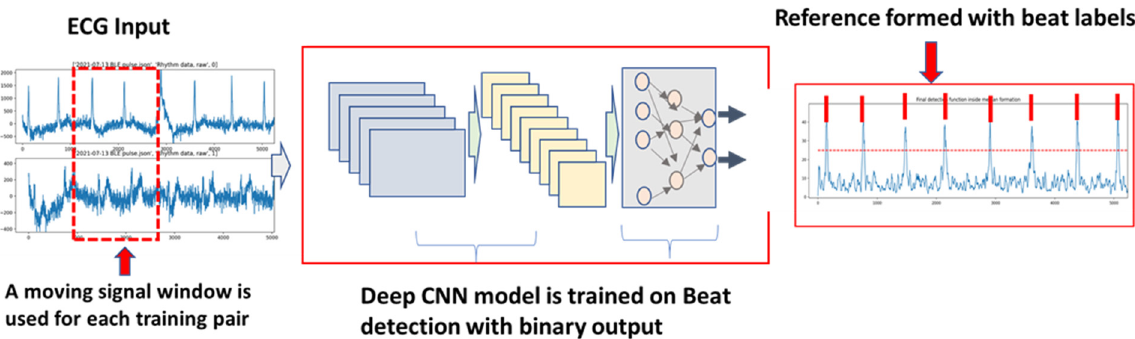
Figure 5. DL models can be trained for beat detection and classification directly from ECG waveform. The key is to define the input/reference pair. The label can indicate beat type and noise segment.